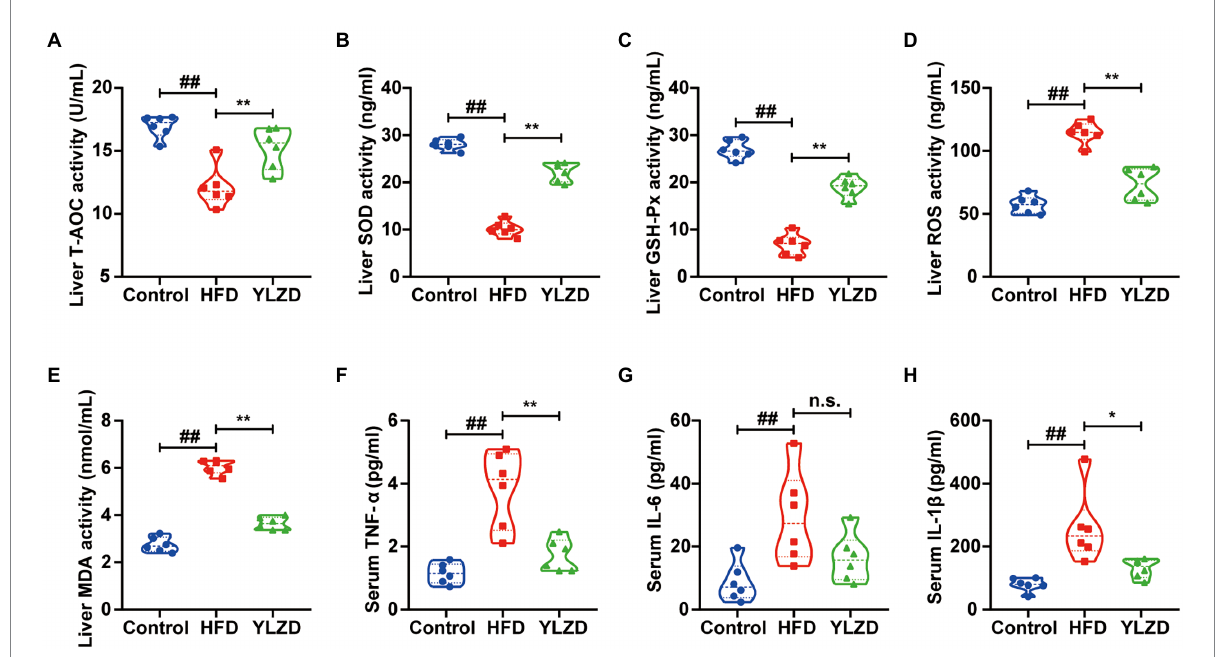
FIGURE 2 YLZD alleviated oxidative stress damage and reduced NAFLD-related systemic inflammation. Liver homogenate levels of (A) T-AOC, (B) SOD, (C) GSH-Px, (D) ROS and (E) MDA, respectively. Serum levels of (F) TNF- α , (G) IL-6 and (H) IL-1 β , respectively. Values are represented as mean ± SEM ( n = 6 rats/group). ## p < 0.01 versus the Control group; ** p < 0.01, * p < 0.05 versus the HFD